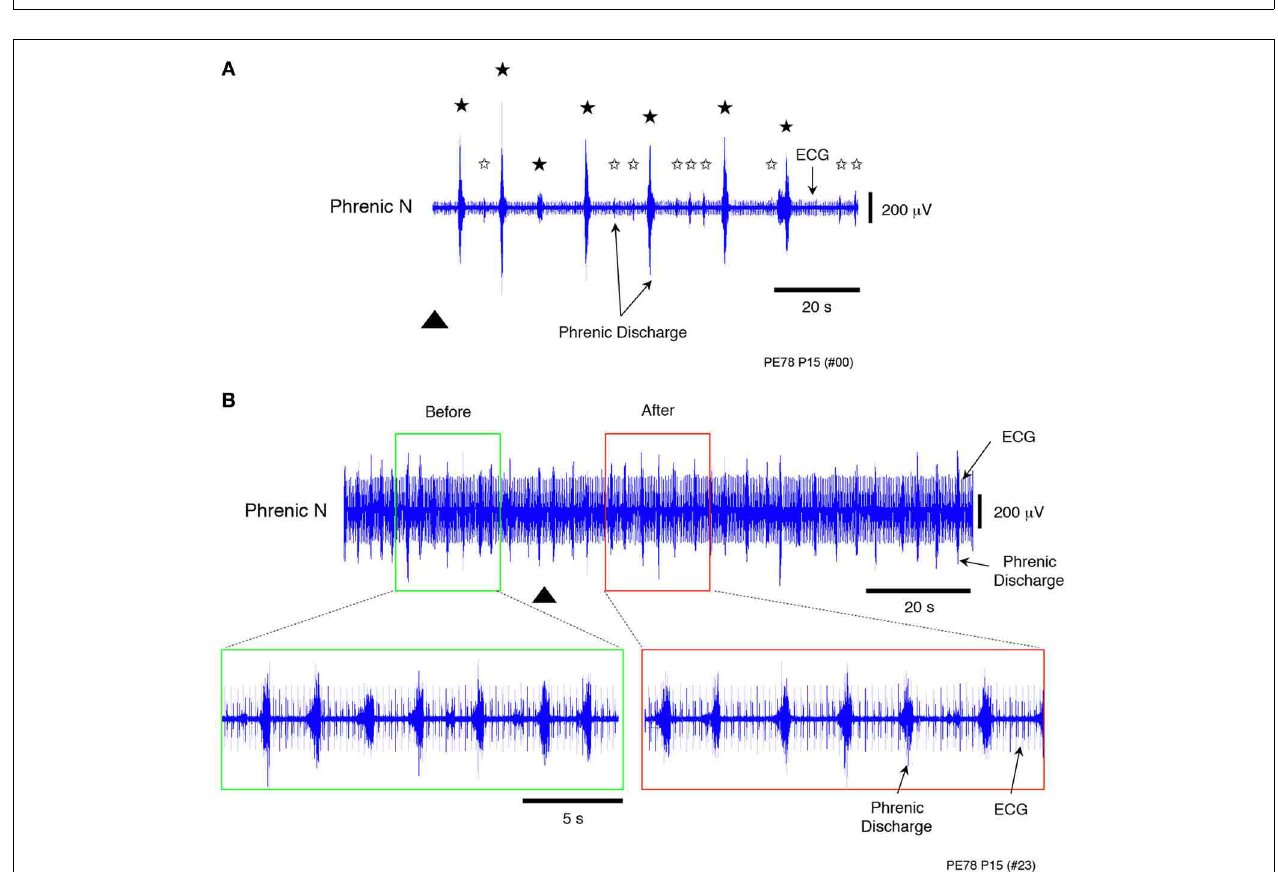
FIGURE 4 | Continued were extracted from the data collected from one experiment. Cross-correlation analysis of left phrenic and left tibial nerve discharge during discharge episodes and computation of the correlation in the time domain between lags from − 2.5 to 2.5s were also performed. In (2) , the phrenic discharge positioned the tibial discharge to right of the vertical